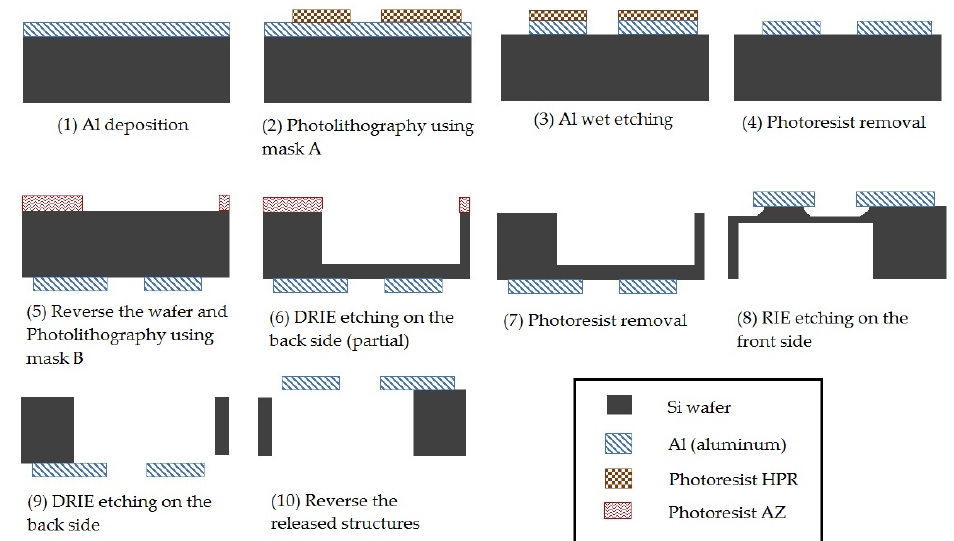
Figure 2. Flowchart of the micro-tweezer fabrication process: (1) Aluminum deposition on the Si substrate; (2) Photolithography using first mask A and HPR photoresist; (3) Aluminum wet etching; (4) HPR photoresist wet removal; (5) Reverse of the wafer and photolithography using AZ photoresist on the back side using second mask B; (6) Partial DRIE etching on the back side of the wafer; (7) AZ photoresist wet removal; (8) Reverse of the wafer and RIE etching on the front side of the wafer to release the structures; (9) Reverse of the wafer and complete DRIE etching of the Si wafer; (10) Reverse of the wafer with released structures and